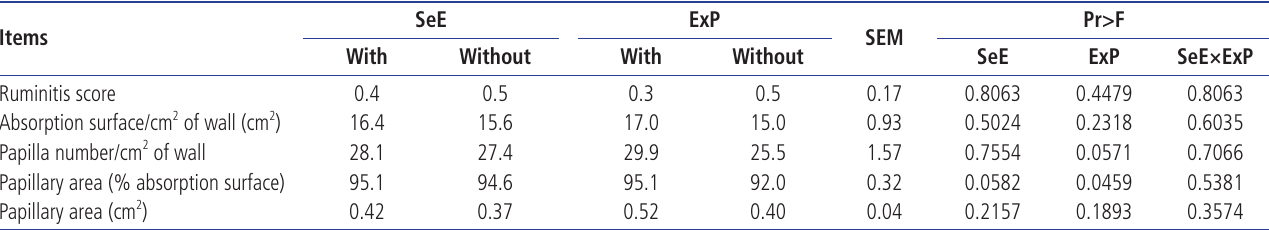
Table 4. Average ruminitis score and ruminal wall morphology of Dorper×Santa Ines lambs receiving a high-concentrate diet with different antioxidant additives Items